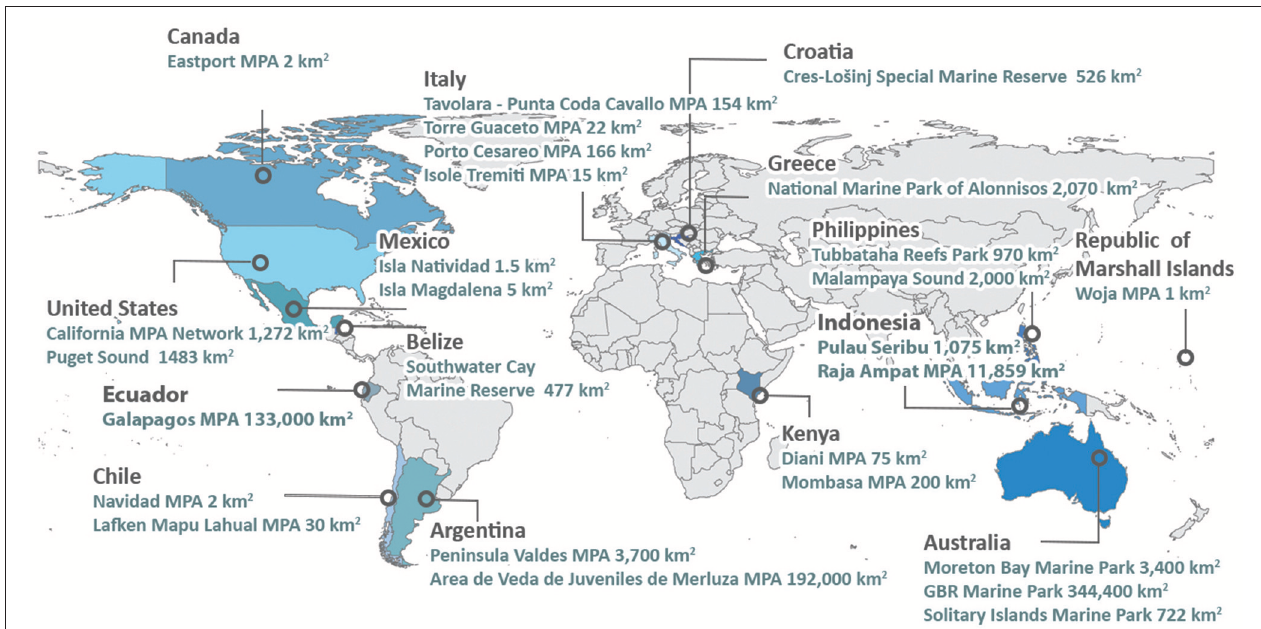
FIGURE 1 | Distribution of 27 MPA case studies across the world. For clarity, the color scheme reflects the different countries of our case studies. Location markers are not reflective of MPA placement within countries.